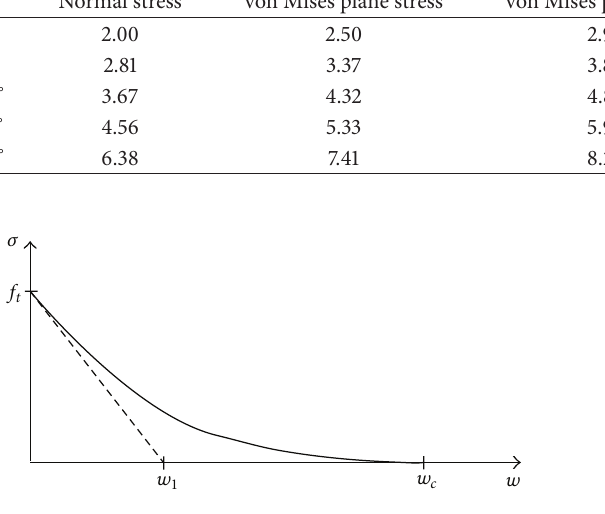
Figure 3: Cohesive softening function and initial linear approxima- tion.